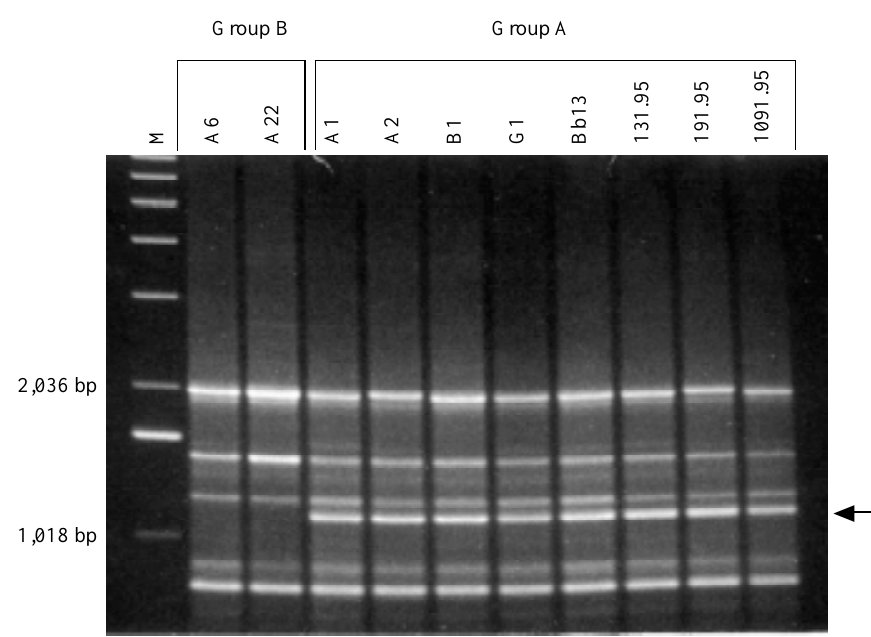
Fig. 1. Banding patterns of Phaeomoniella chlamydospora isolates generated by RAPD primer OP-B18 and separat- ed by 1% agarose gel electrophoresis. M designates the 1 kb DNA ladder; size is shown at the left of the gel. Arrow indicates the polymorphic band.